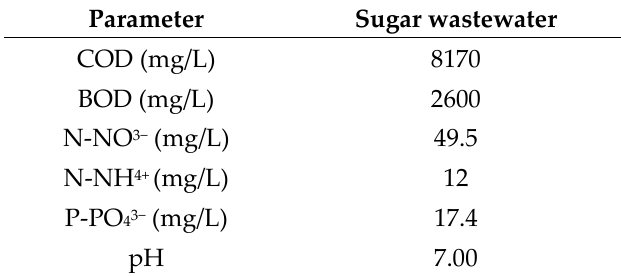
Table 1. Physico-chemical characteristics of the treated wastewater subjected to pressure membrane filtration.